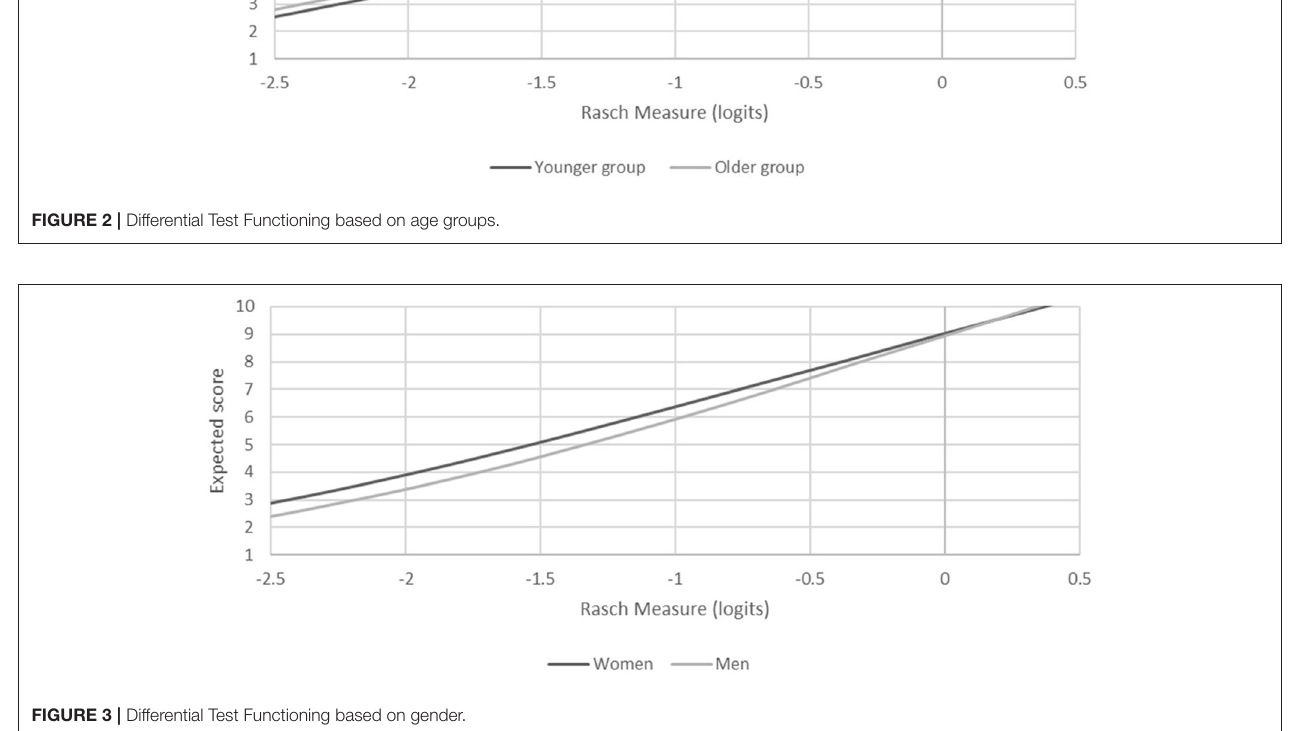
FIGURE 3 | Differential Test Functioning based on gender.